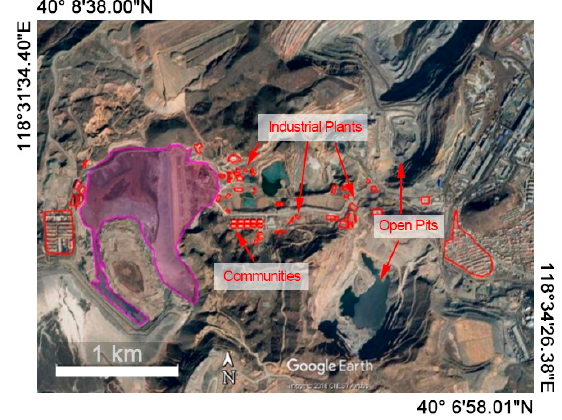
Figure 10. Locations of the ‘overhead tailings pond’ and nearby important facilities.